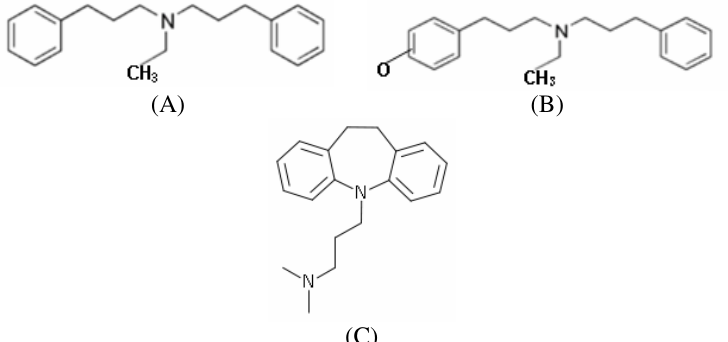
Figure 1. Structures of (A) Alverine; (B) Monohydroxy alverine and (C)